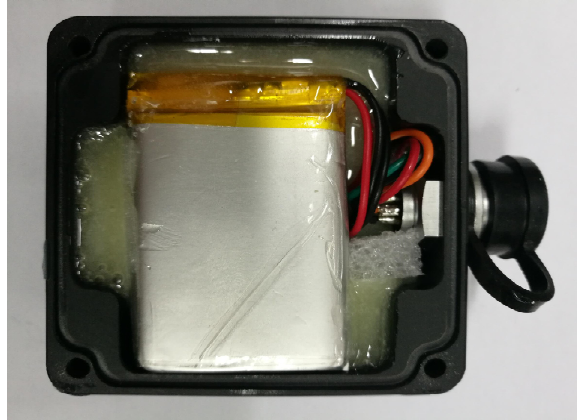
Figure 11. Internal view of sensor’s case after glue filling.